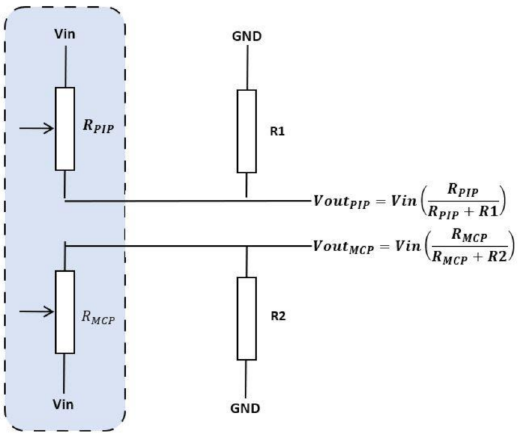
Figure 8. Custom 2-in-1 combined Flexpoint sensor with voltage divider circuits.